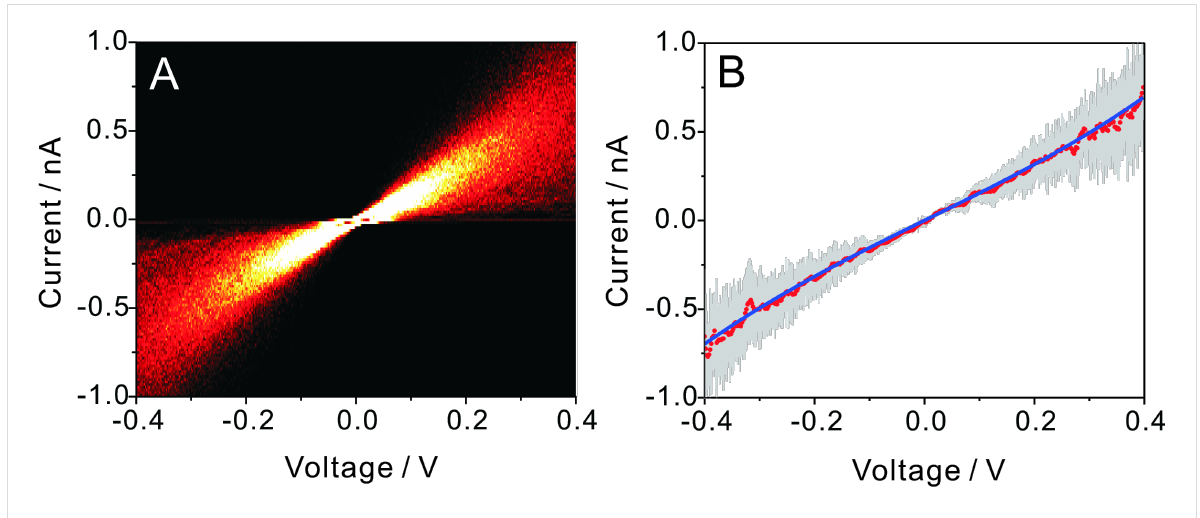
Figure 6: (A) 2-D I–V histogram constructed from 2500 individual traces recorded during a current–distance stretching experiment, stretching rate 0.5 nm·s − 1 , in the molecular junction region for 0.1 mM AC in THF/decane. (B) I–V “master curve” (red) and its standard deviation (error bar) obtained from Gaussian fits at constant bias voltages of the data plotted in panel A, and the corresponding model fitting